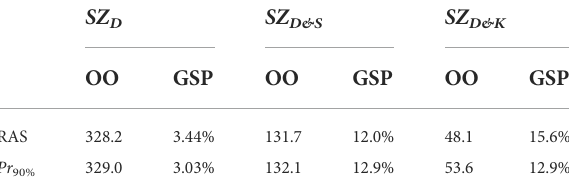
TABLE 3 Pre-operative planning results with different native safe zonesandsurgicalprecisions.OO=optimization objective; GSP= global success